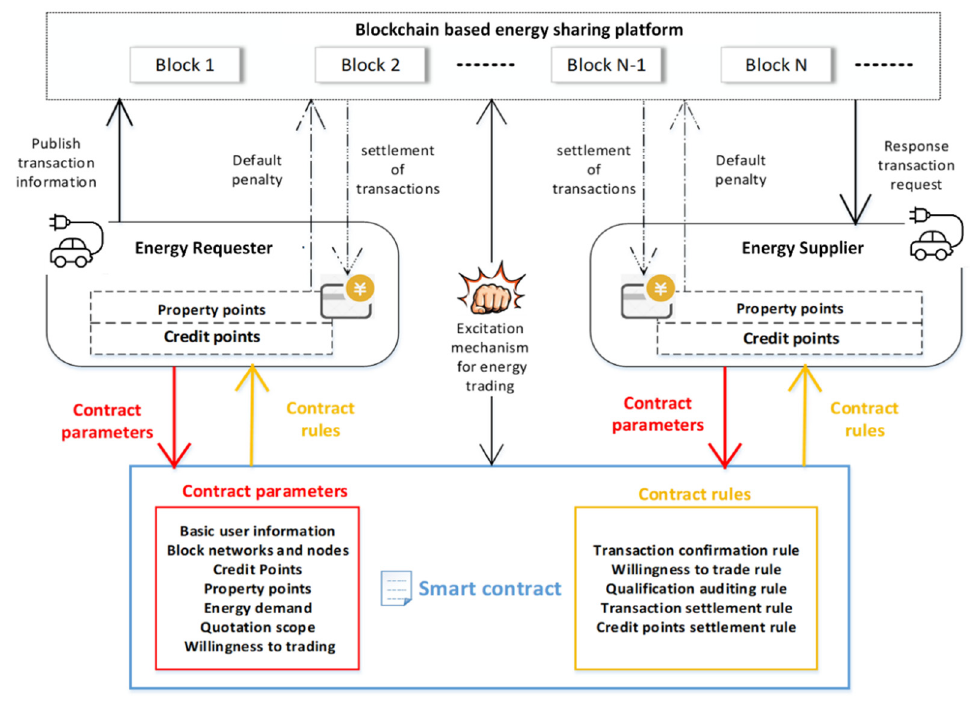
Figure 1. The energy trading process using smart contract.